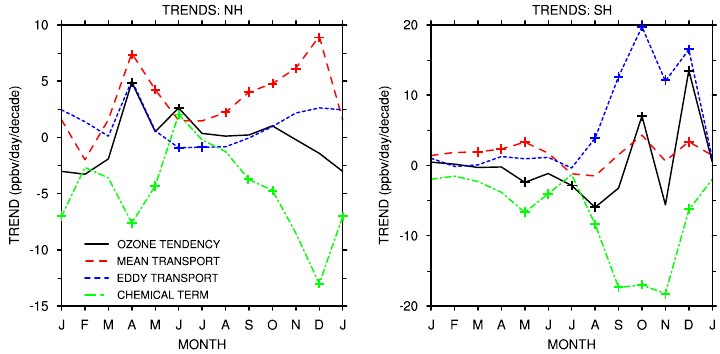
Fig. 6. Annual cycle of the trends in the ozone tendency and its forcing terms, for the (left) NH and the (right) SH. The trends are calculated over the 1980–2001 period based on monthly means of the various forcing terms averaged between 100 and 20hPa and between 60 ◦ –85 ◦ . Trends that are statistically significant at the 95% statistical significance level are indicated by a cross.